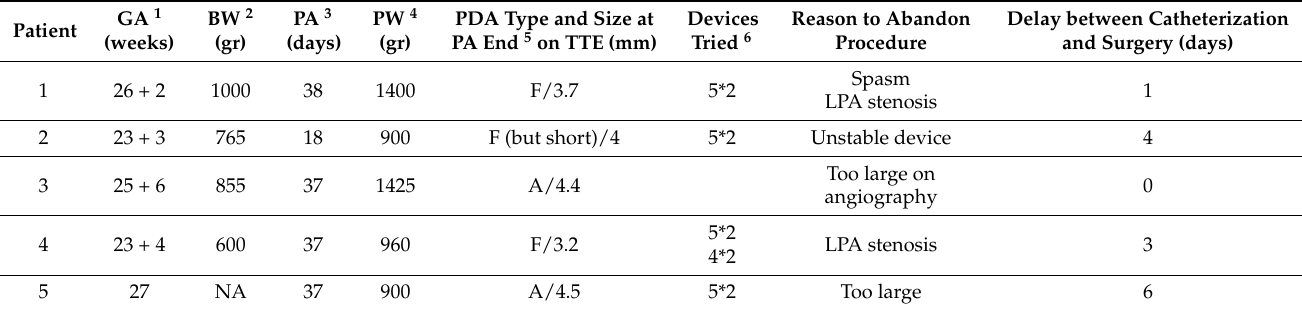
Table 2. Characteristics of the five patients who needed surgical ligation after attempted percutaneous closure.